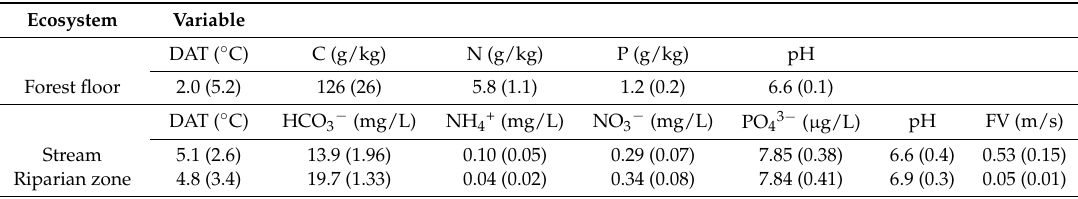
Table 1. Mean values for the characteristics of the local-scale environmental variables in the three types of studied ecosystems during the two-year